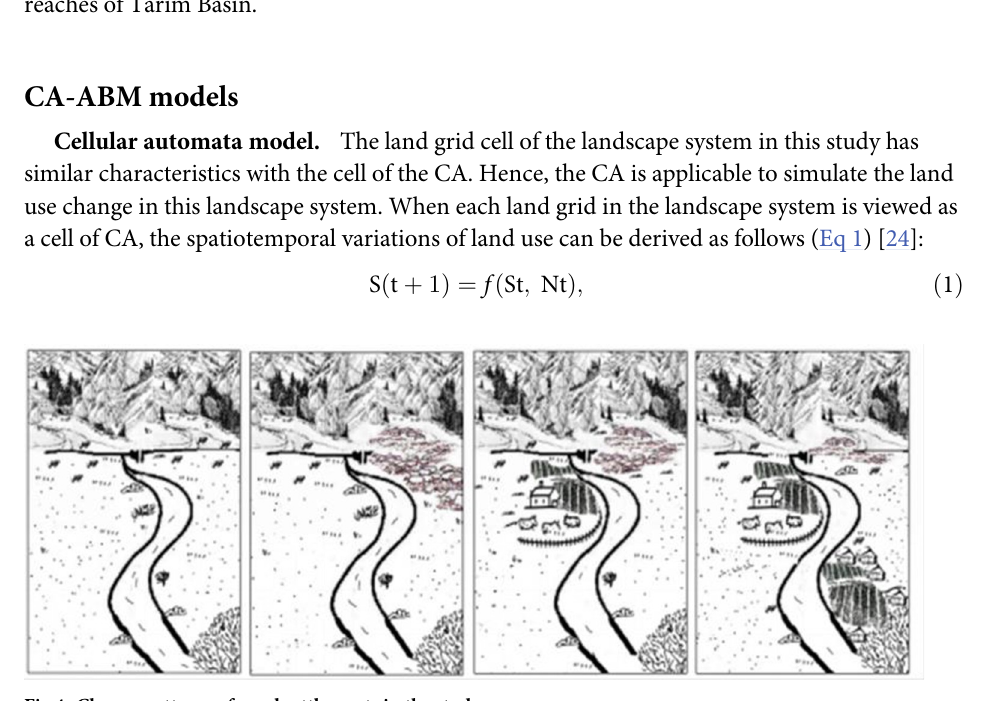
Fig 4. Change patterns of rural settlements in the study